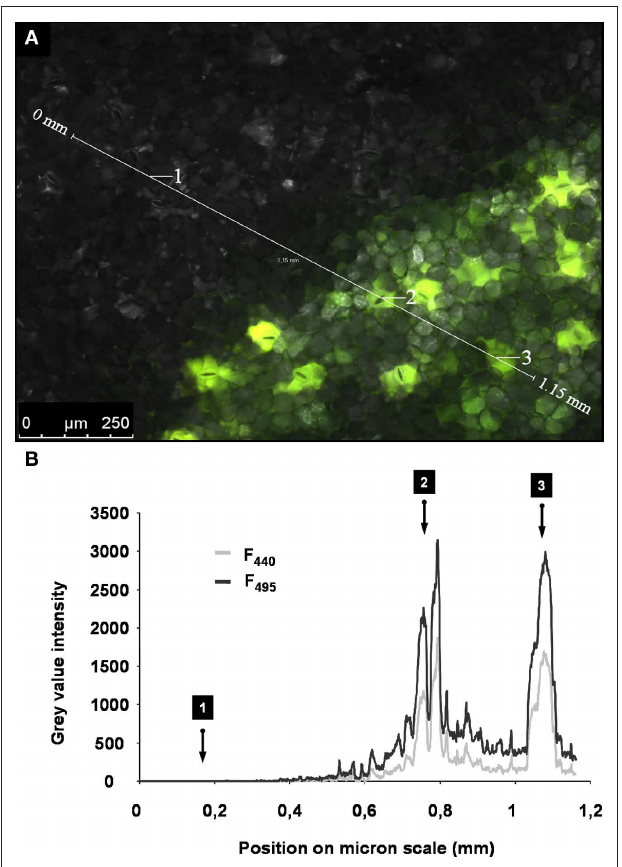
Figure 6 | Specific dye signals versus unspecific noise signals. (A) Adaxial leaf face. Overlay of ex 495 nm pseudo-green fluorescence image, ex 440 nm pseudo-red fluorescence image, and the corresponding bright-field image (gray-scaled). The apoplast was partially loaded with the dye (lower right part of the image). Dye-loaded areas appear light green when illuminated, because pseudo-red and pseudo-green are mixed within the overlay. The gray area was not loaded with the dye (upper left part of the image). Such a specimen represents a suitable object to compare the amount of unspecific signals (noise) to specific signals being emitted from the dye. The intensity of gray values was chosen as a measure for signal intensity. A profile of the gray-value intensity was taken from the area tagged with the scale bar (1.15 mm length; white line in A ) and is presented in (B) . This profile is displayed for both fluorescence excitation channels (ex 495 and ex 440 nm). Negligible signals were emitted from the area of the leaf without dye (i.e., detail 1). The signals were much higher in the dye-loaded areas (i.e., detail 2 and 3; in both cases, signal intensity at